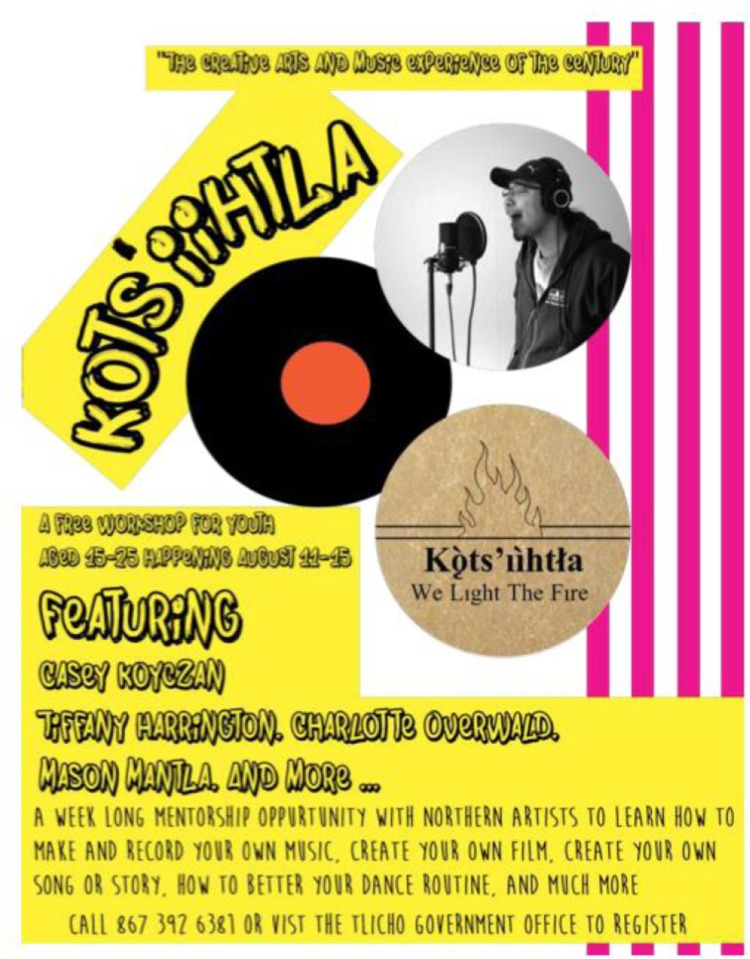
Promotional poster for the Kts'iìhtła Workshop.